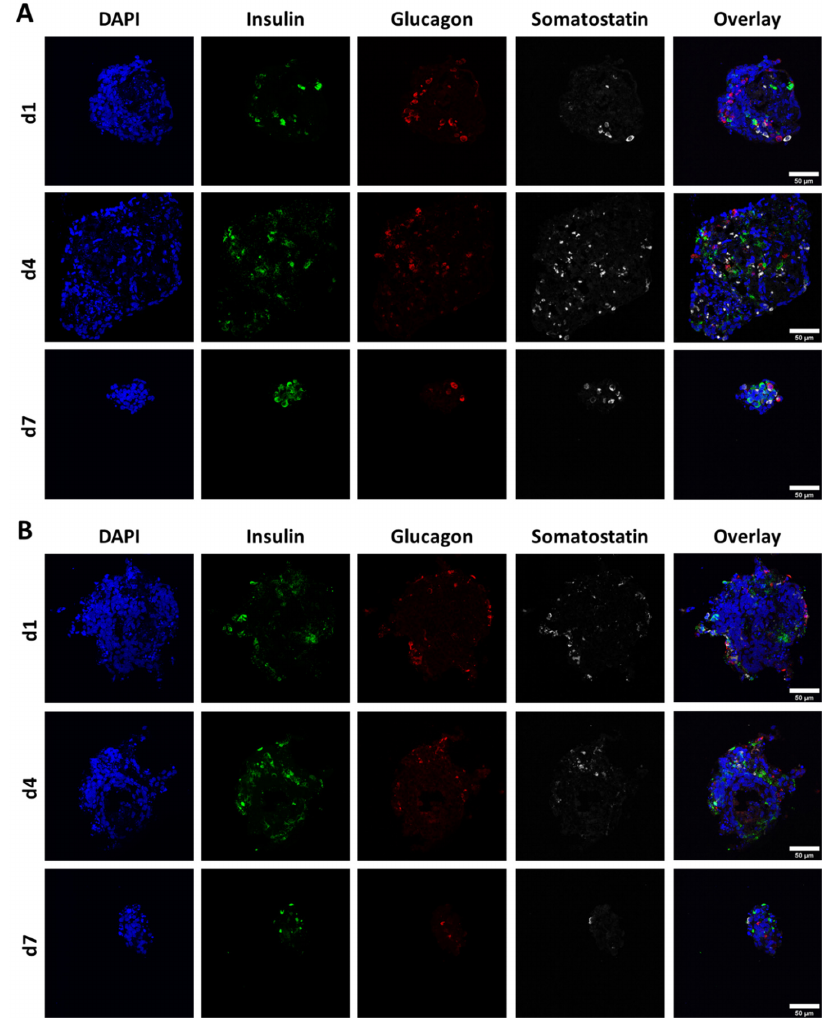
Figure 4. Representative images of NICC immunofluorescently stained for nuclei (DAPI), insulin, glucagon, and somatostatin. ( A ) Free control NICC; ( B ) NICC in bioprinted PBS-algMC scaffolds. Samples were incubated for 1, 4, or 7 d under cell culture conditions. Scale bars = 50 µm.